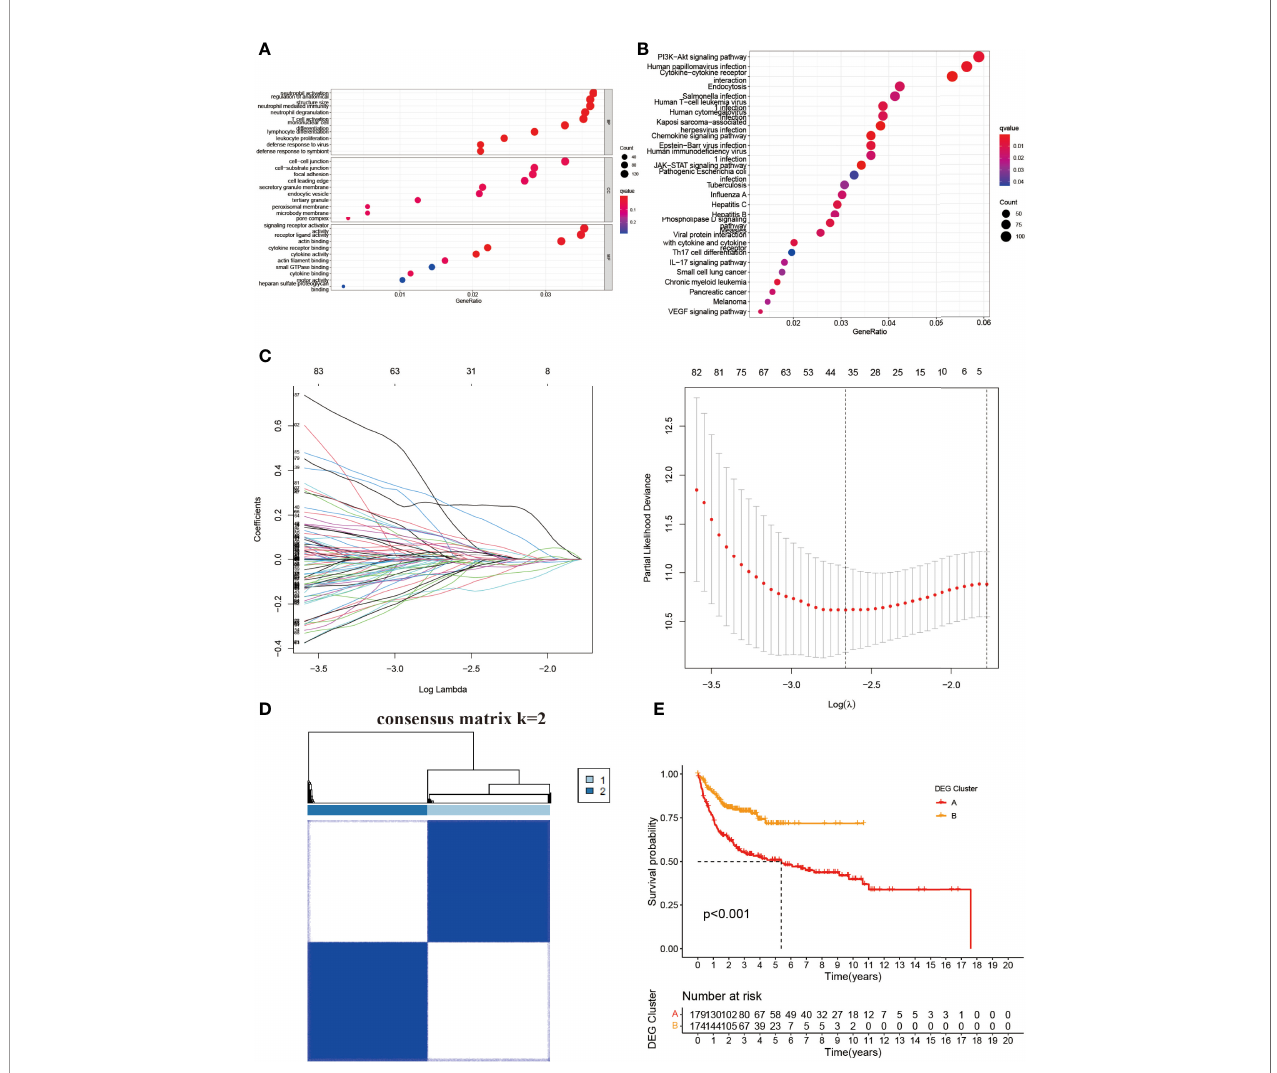
FIGURE 3 | Identi fi cation and construction of NRG-based DEG clusters. (A) GO and (B) KEGG analysis of the differential genes between two NRG clusters. (C) LASSO and Cox proportional hazard model construction between NRG clusters. (D) The consensus matrix by cluster analysis based on DEGs. Two clusters would be best. (E) Kaplan – Meier survival curves of two DEG clusters ( p < 0.001). BP, biological process; CC, cellular component; MF, molecular